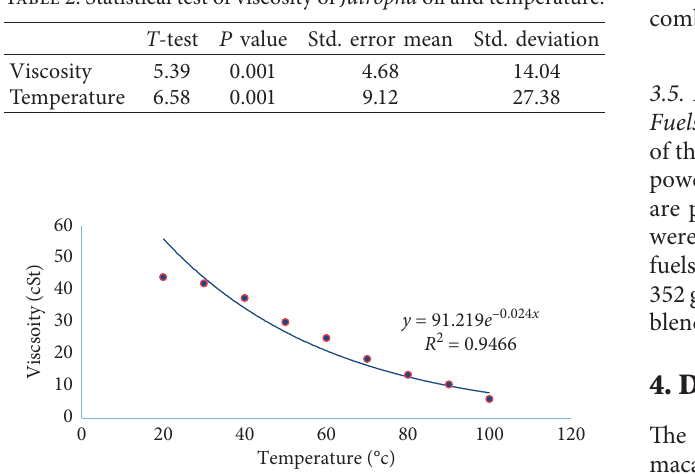
Figure 3: Approximate graph for the temperature-viscosity